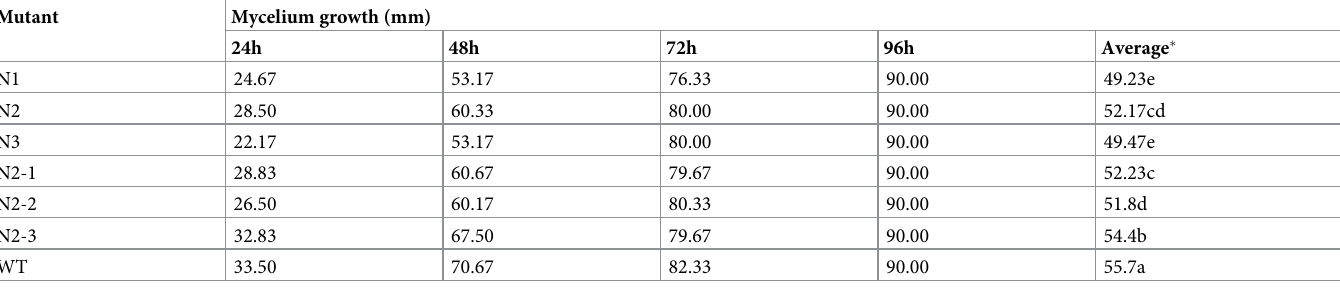
Table 1. Growth and morphological characterization of NTG induced Trichoderma mutants. Mutant